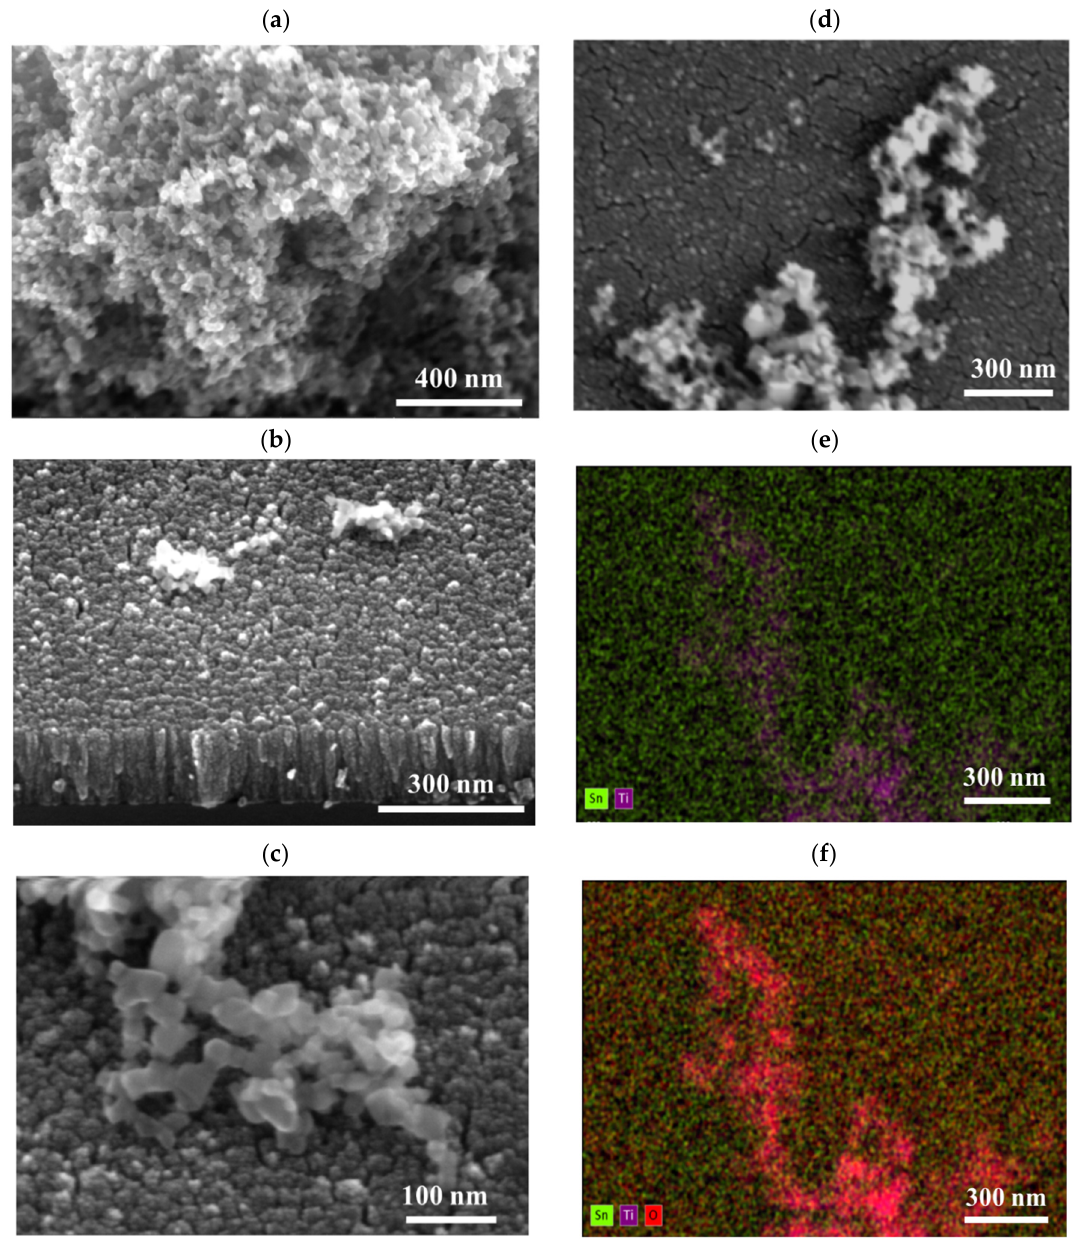
Figure 7. SEM images for TiO 2 grown by the Langmuir–Blodgett method on the surface of a-SnO 2 thin films deposited by magnetron sputtering MS: cross sections ( a , b ), top view ( c , d ) and EDS maps of Sn, Ti, O elements ( e , f ).